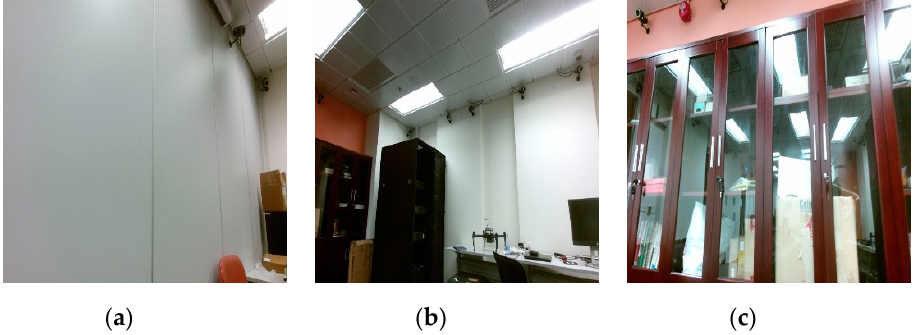
Figure 7. Challenging scenes. ( a ) Low texture; ( b ) Illumination variation; ( c ) Glass window.